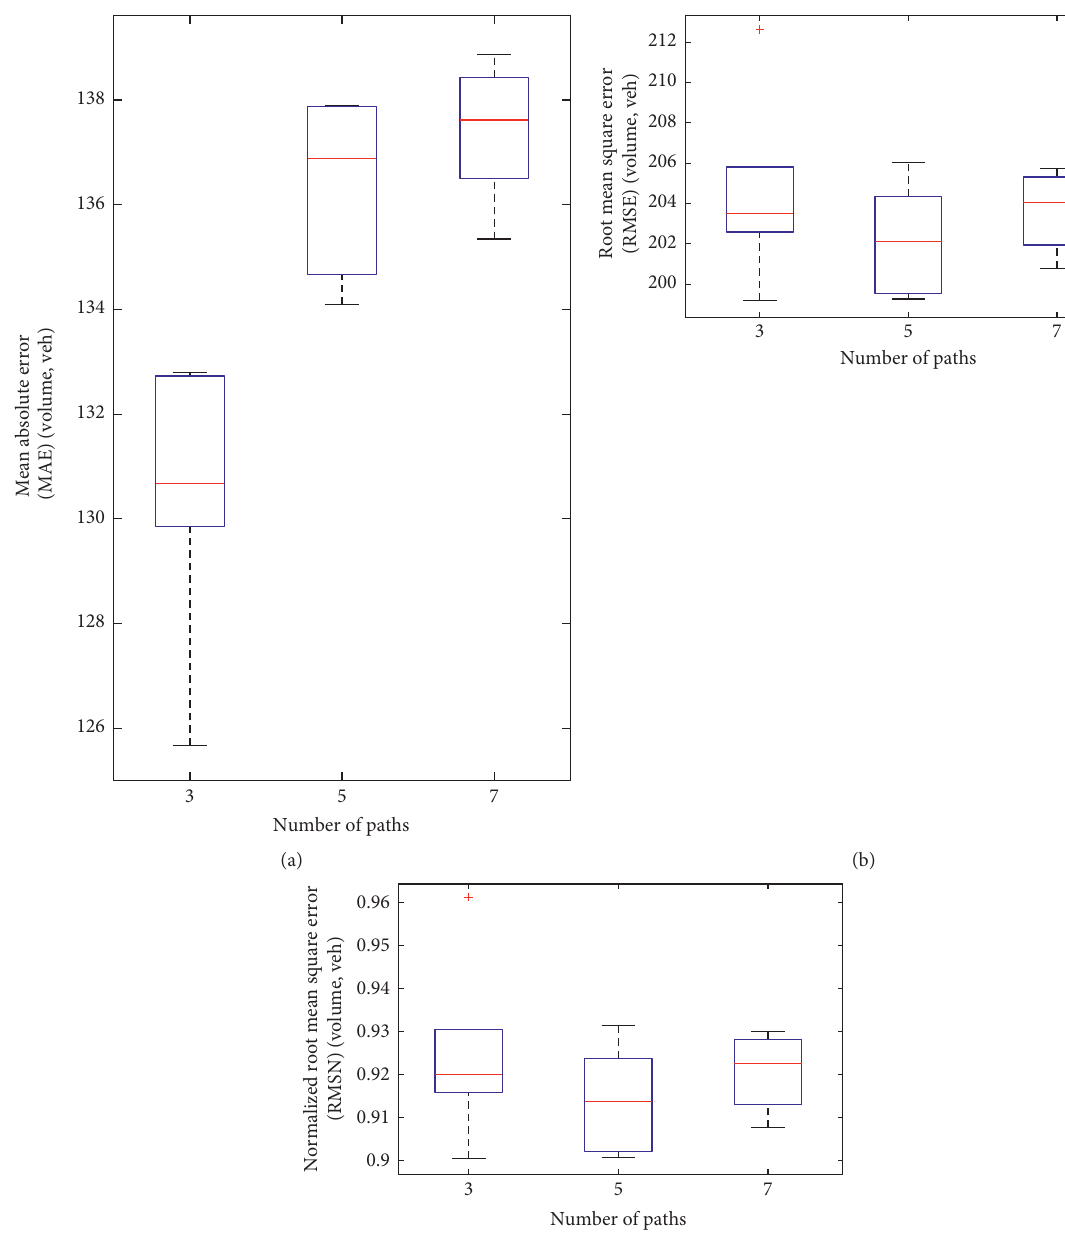
Figure 4: A comparison of the accuracy of the SRC solution when 3, 5, and 7 paths are used in the assignment with a fixed 30% adaptive driving percentage and five replications against real-world link volumes: (a) MAE, (b) RMSE, and (c)